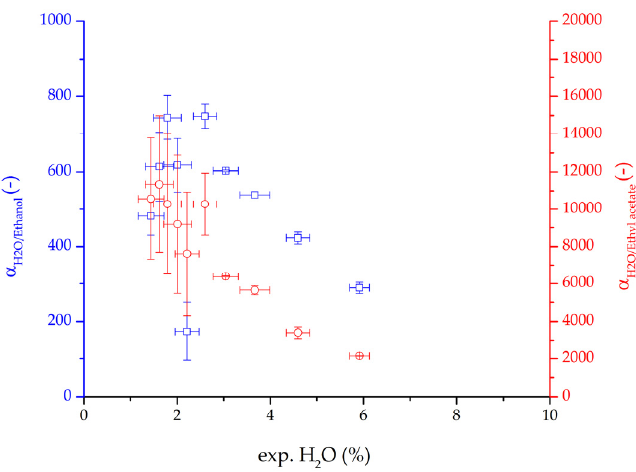
Figure 21. Binary water/ethanol selectivity (blue squares) and water/ethyl acetate selectivity (red circles plotted over the water mass fraction (feed) for the ternary system. The error bars represent the standard deviation.